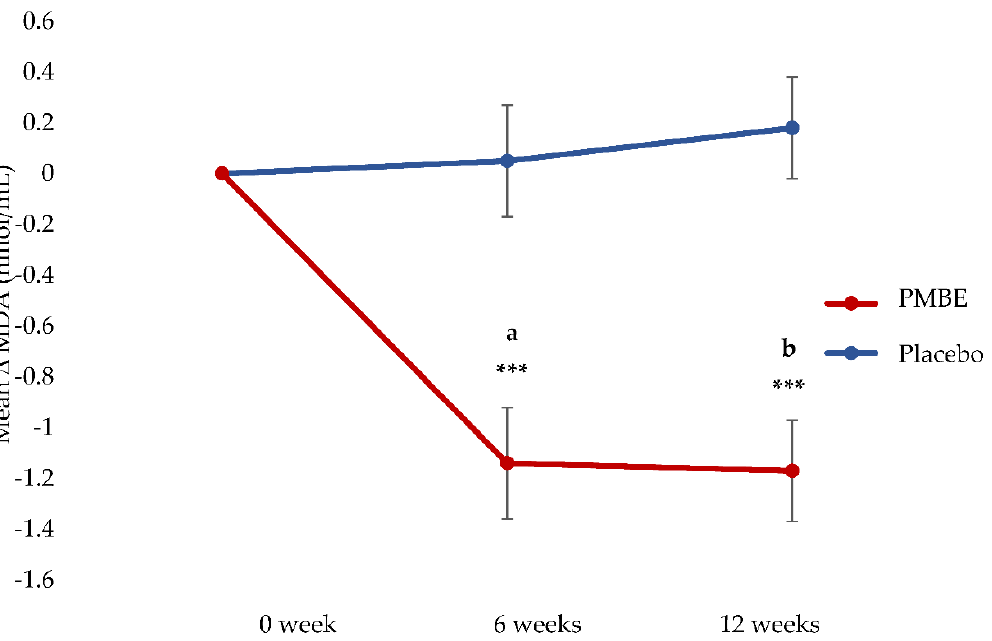
Figure 2. Mean change in MDA concentrations (with standard error bars) over time in the placebo and PMBE groups. Significant change from baseline is indicated by *** p < 0.0001; ( a ), mean change between PMBE group and placebo group at 6 weeks was statistically significant ( − 1.23 nmol/mL, 95% CI − 1.84 to − 0.62, p < 0.0001). ( b ), mean change between PMBE group and placebo group at 12 weeks was statistically significant ( − 1.53 nmol/mL, 95% CI − 2.09 to − 0.98, p < 0.0001).